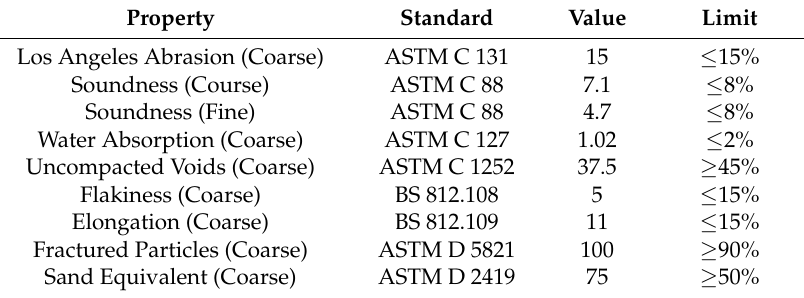
Figure 2. Gradation Curve of aggregates used for asphalt mixtures. Table 3. Material Properties of Margalla aggregate used in this research [31].